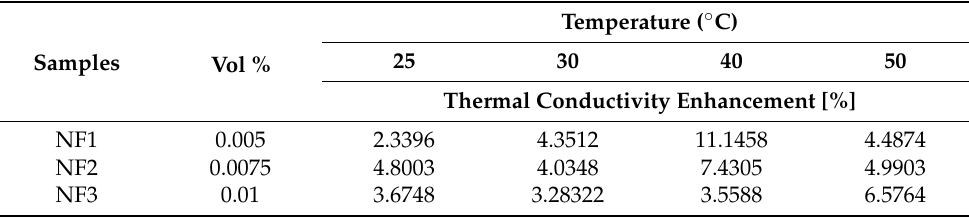
Table 5. Student ’s t -test parameters on thermal conductivity data corresponding to 95% confidence interval.